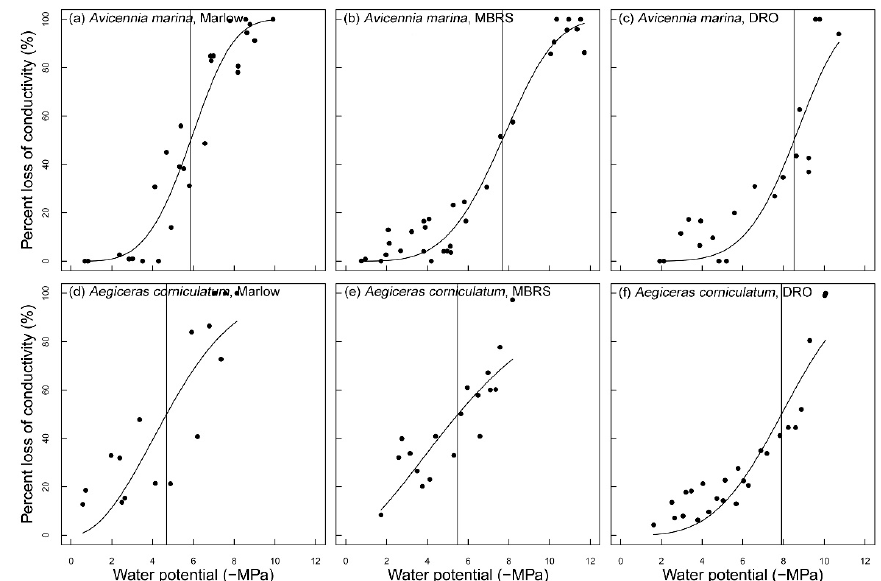
Figure 1. Percentage loss of xylem conductivity to water potential of two mangrove species. Black vertical lines indicate xylem water potential inducing 50% loss of conductivity (P 50 ). Stem vulnerability curve of Avicennia marina across three sites ( a – c ) and the vulnerability curve of Aegiceras corniculatum across three sites ( d – f ).